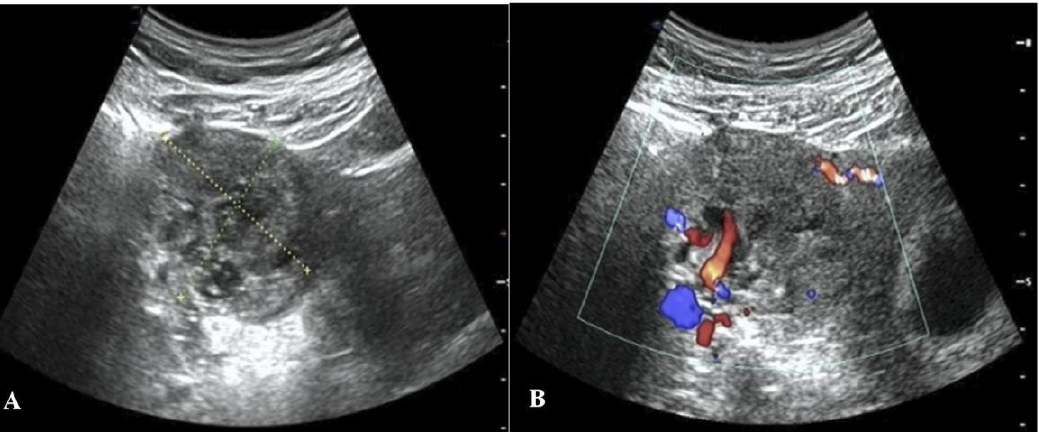
Figure 2. Ultrasound images on the 14th day after the injection of MTX. ( A ) A two-dimensional ultrasound image, which reveals the growth of the ectopic gestational sac. ( B ) A color Doppler ultrasound image showing an abundant blood flow signal around the IP.